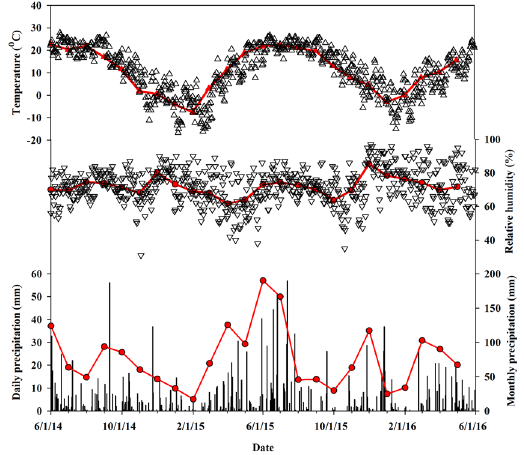
Figure 1. Daily (triangle and vertical bars) and monthly (red lines) precipitation, temperature and relatively humidity at Zionsville meteorological station between June 2014 and May 2016.